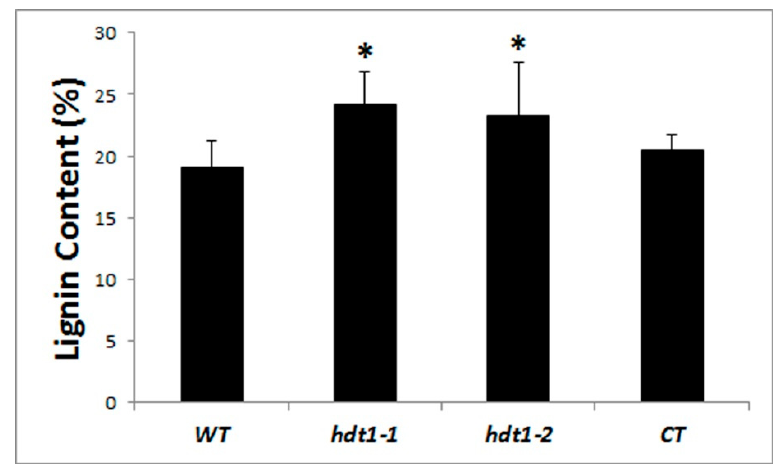
Figure 3. Lignin content in the stems of wild type, hdt1-1 , hdt1-2 , and the complementation transgenic line at the T3 stage. (*, 0.01 < p -value < 0.05).